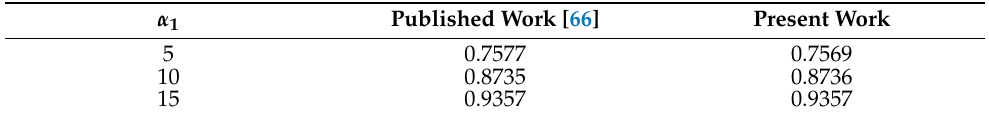
Table 2. Comparative numerical values of the skin friction coefficient with published result with